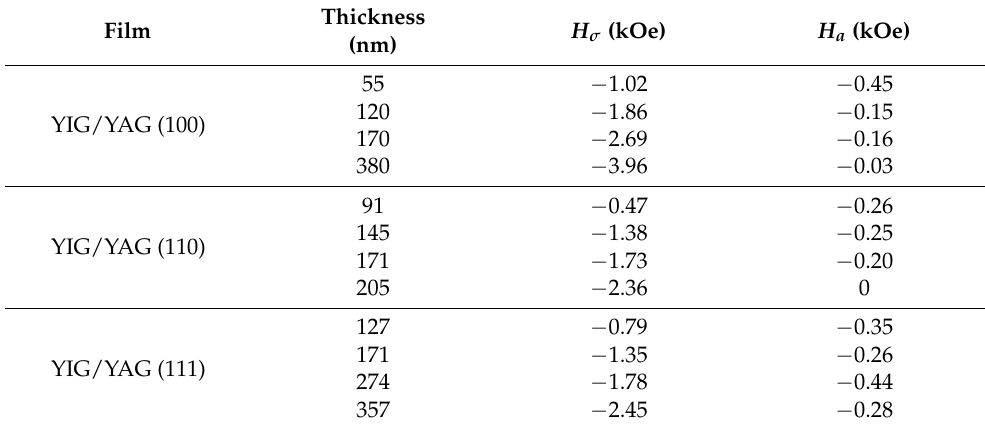
Table 3. The strain anisotropy field H σ estimated from XRD data and growth induced anisotropy field H a determined from FMR